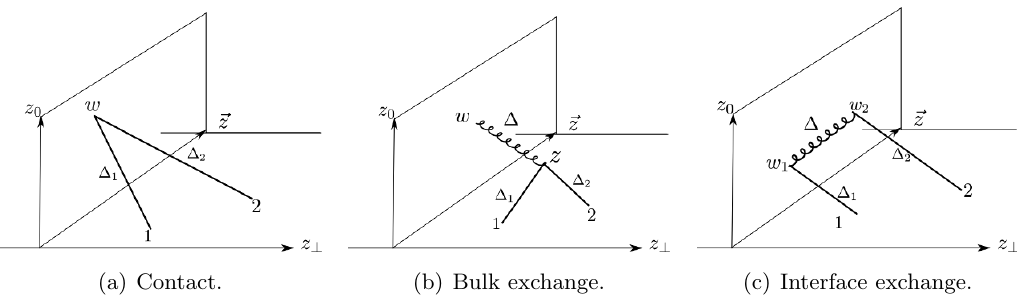
Figure 1 . Three types of Witten